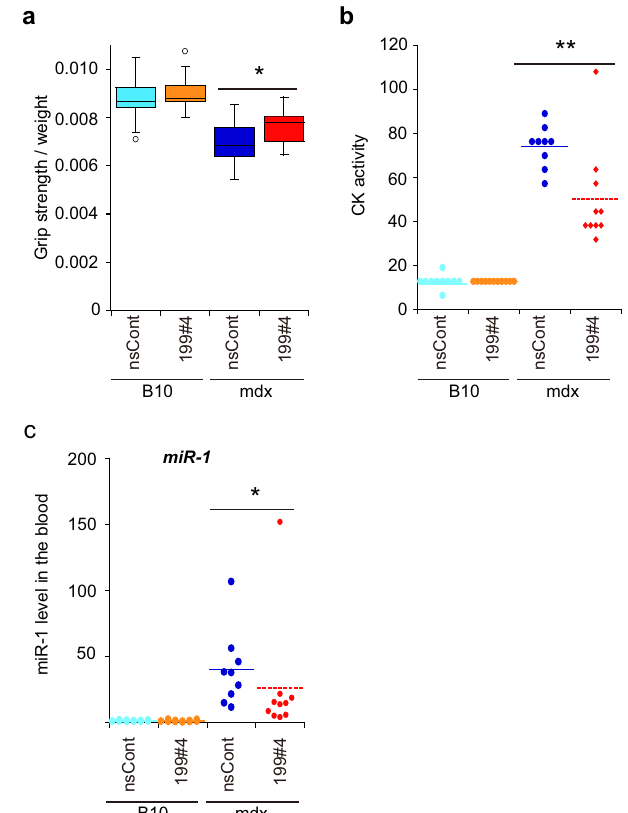
Fig. 8 Effects of miR199#4 on mdx mice. a Grip strength test of mdx mice. Mdx and B10 control mice (8-week-old) were injected twice intravenously with miR199#4 (199#4) and nsCont, and examined by the grip strength test 1 week after the last administration. The fi rst two grip strength data were normalized by body weight and averaged. The number of mice examined was as follows: 13 miR199#4-dosed mdx mice, 12 nsCont-dosed mdx mice, 11 miR199#4-dosed B10 mice, and 13 nsCont-dosed B10 mice. Data are shown as mean ± SEM [* p < 0.05 by Student ’ s t test (two-tailed)]. b Creatine kinase (CK) activity. 1 week after the fi rst administration, blood samples were collected and serum CK activity was measured. Data are plotted and shown in an arbitrary unit. Meanscore is indicated by a dotted bar [** p < 0.01 by Wilcoxon rank-sum test]. c Cf-miR-1 in the blood. The level of cf-miR-1 was examined in the same blood samples as b by qRT-PCR and analyzed as in Fig. 1a. The data were normalized with the averaged data of nsCont-dosed B10 mice as 1. Data are plotted, and meanscore is indicated by a dotted bar (* p < 0.05 by Wilcoxon rank-sum test). The number of mice examined in b and c was as follows: 10 miR199#4-dosed nsCont-dosed B10